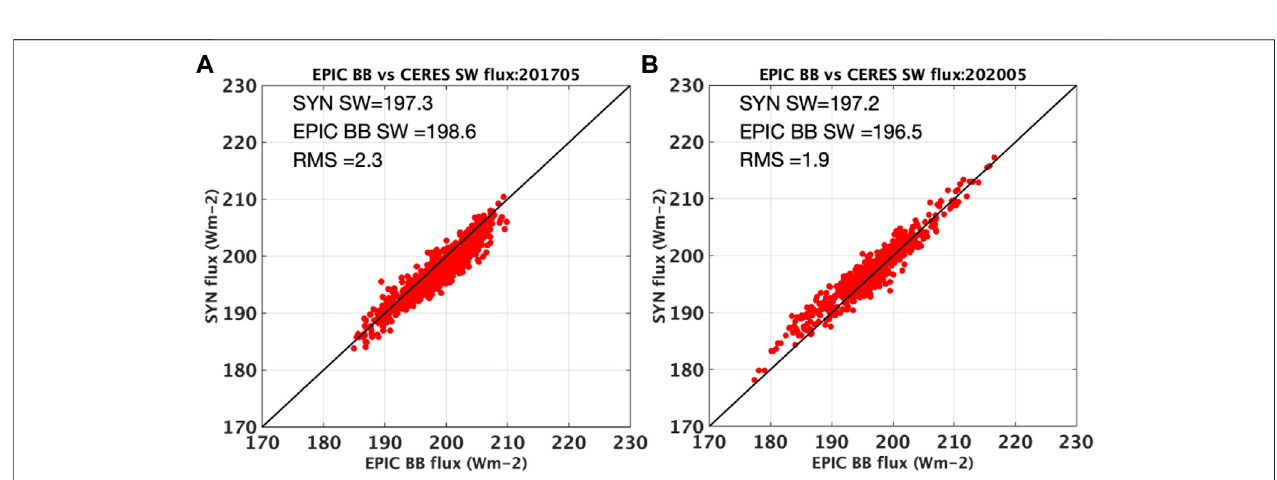
FIGURE 11 | Comparison of global daytime mean shortwave fl ux between EPIC and CERES SYN for May 2017 (A) and May 2020 (B) .